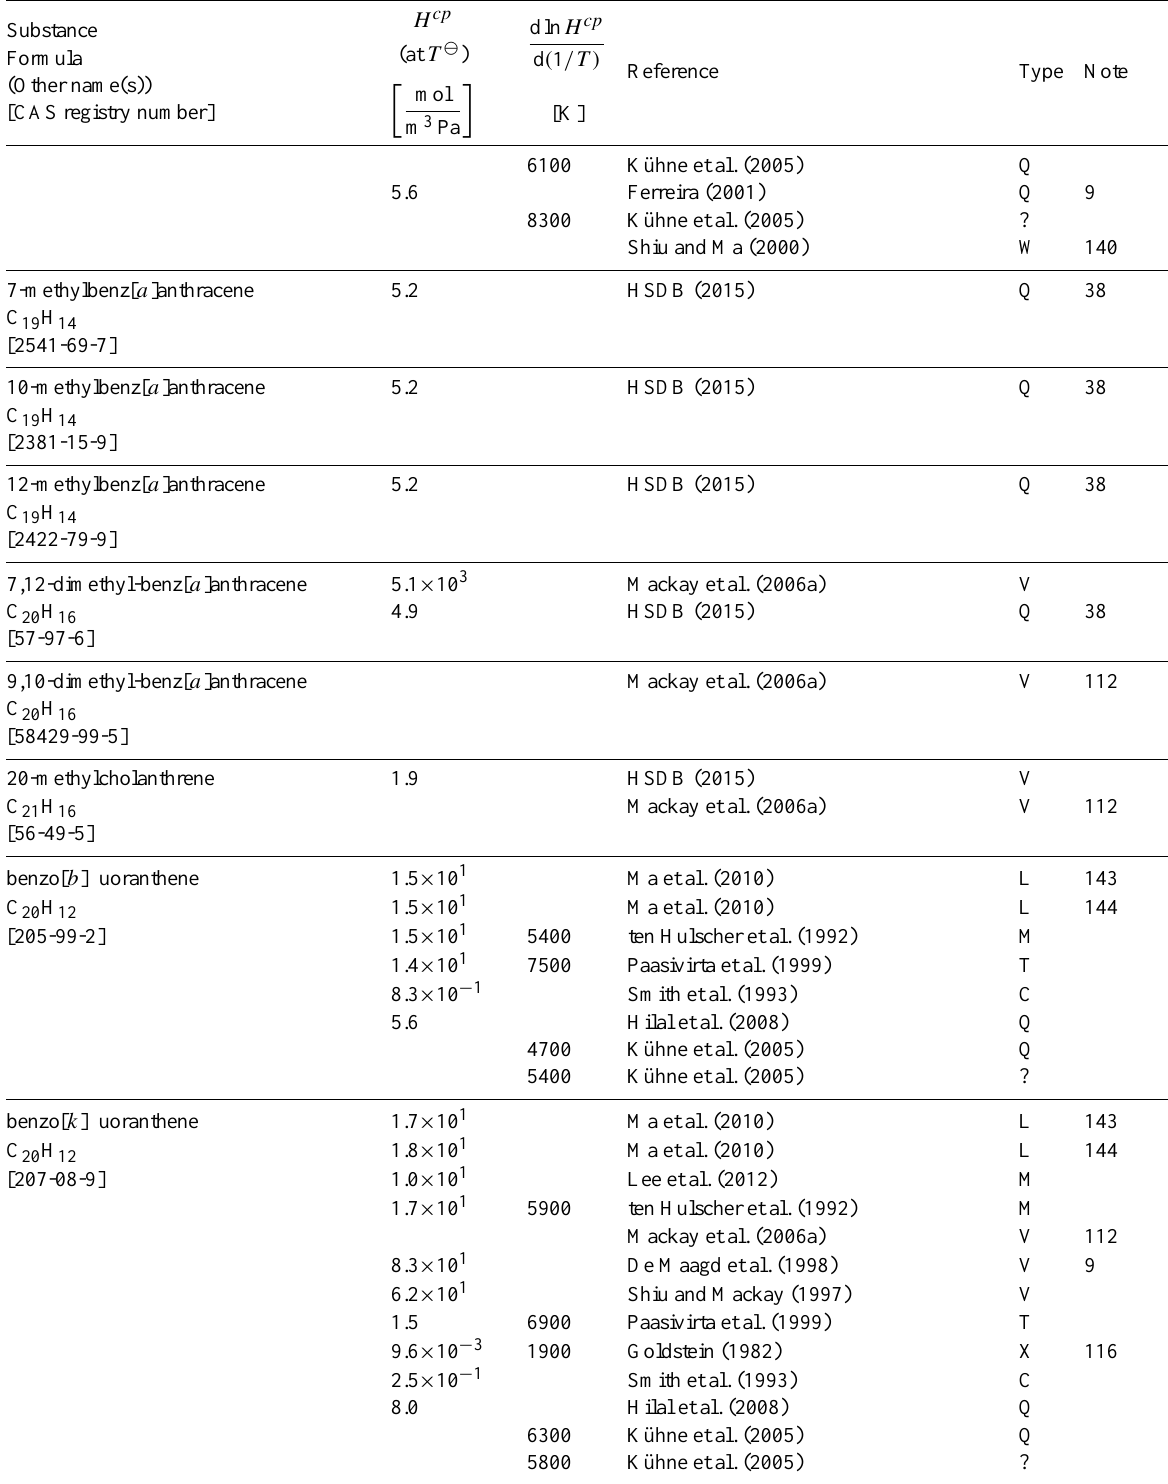
Table 6: Henry’s law constants for water as solvent